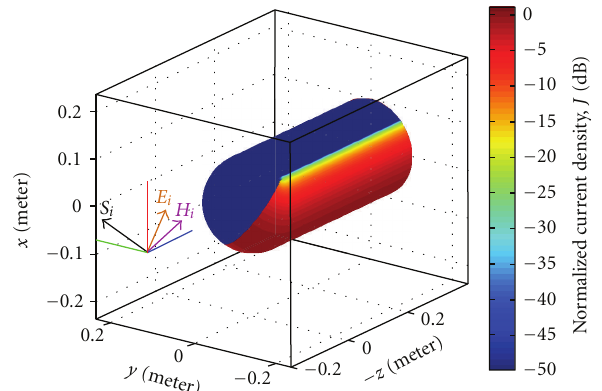
Figure 7: Surface current density using modified PO method for an incident field θ = 60 ◦ , φ = 45 ◦